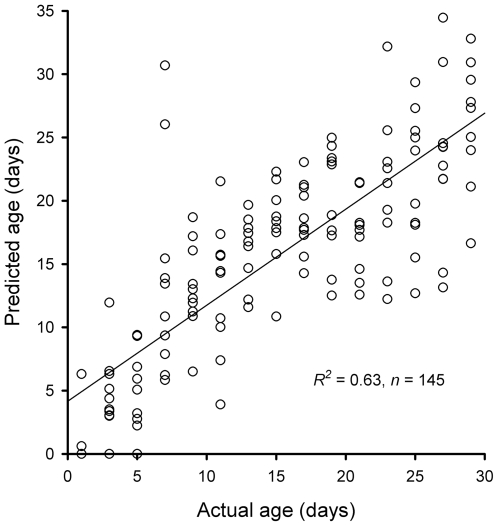
Age predictions of free-range Aedes aegypti from the sentinel-cage derived calibration model.Values are age predictions for individual free-range females (n = 145) derived from nonparametric bootstrap methods. Solid line, least squares linear regression line. Dashed line, predicted equals actual age line.